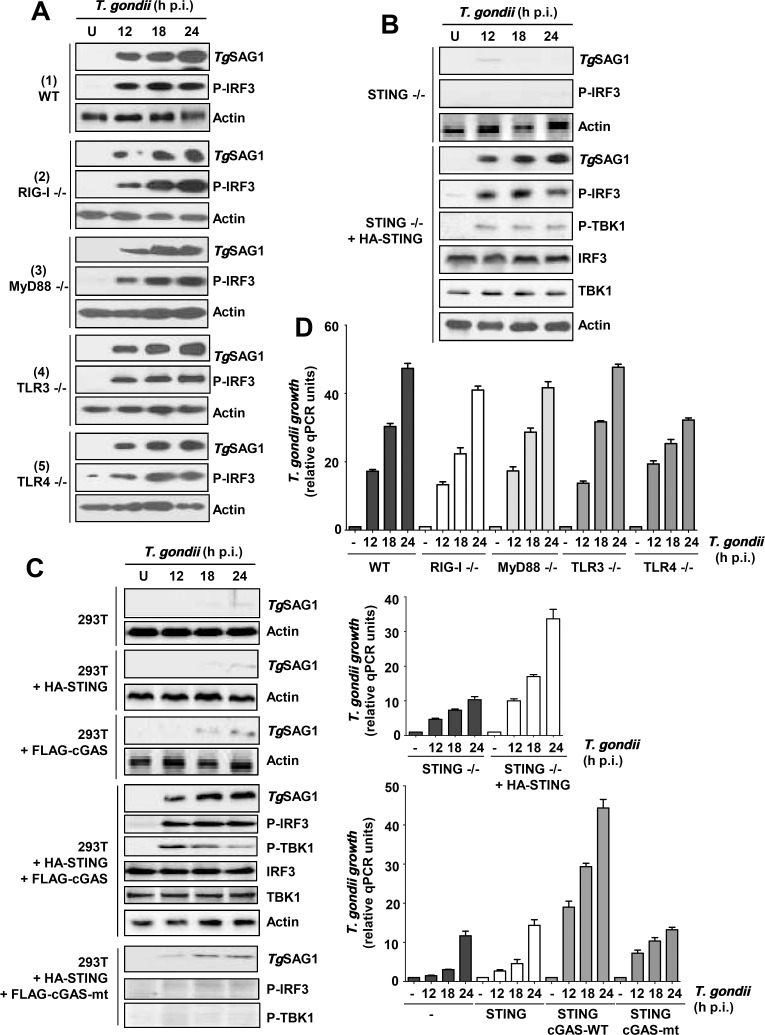
Essential role of a TLR3/4-independent cGAS-STING signaling axis in PISA and optimal T. gondii replication.Parasite infection and growth analyses were performed as in Fig. 1A. A, MEFs (WT, RIG-I-/-, TLR3-/-) and primary macrophages (MyD88-/-, TLR4-/-) were used for comparing PISA (TgSAG1 expression or IRF3 phosphorylation) upon T. gondii infection. B/C, STING-/- MEF cells (B) or human 293T cells (C) were transiently transfected with wild type or mutant (mt) FLAG-cGAS and/or HA-STING plasmids, and infected as shown. D, Parasite growth in various conditions used in the other panels, quantified by qPCR; error bars are from three data sets.